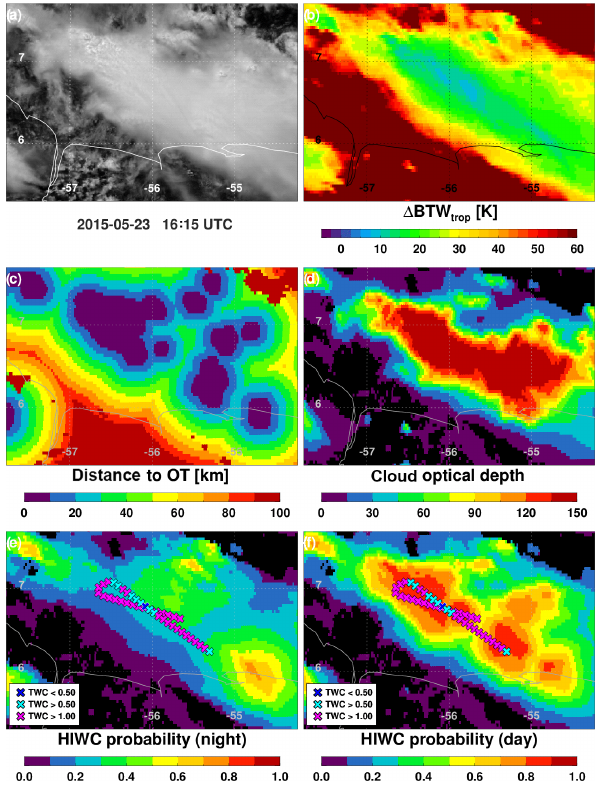
Figure 9. A series of GOES-13 observations and derived products for an image during Falcon 20 Flight 19 of Cayenne-2015, times- tamped at 16:15UTC but valid over French Guyana at 16:25UTC on 23 May 2015. The panels are the same as those described for Fig. 7. The 45s mean TWC observations are valid from 16:15 to